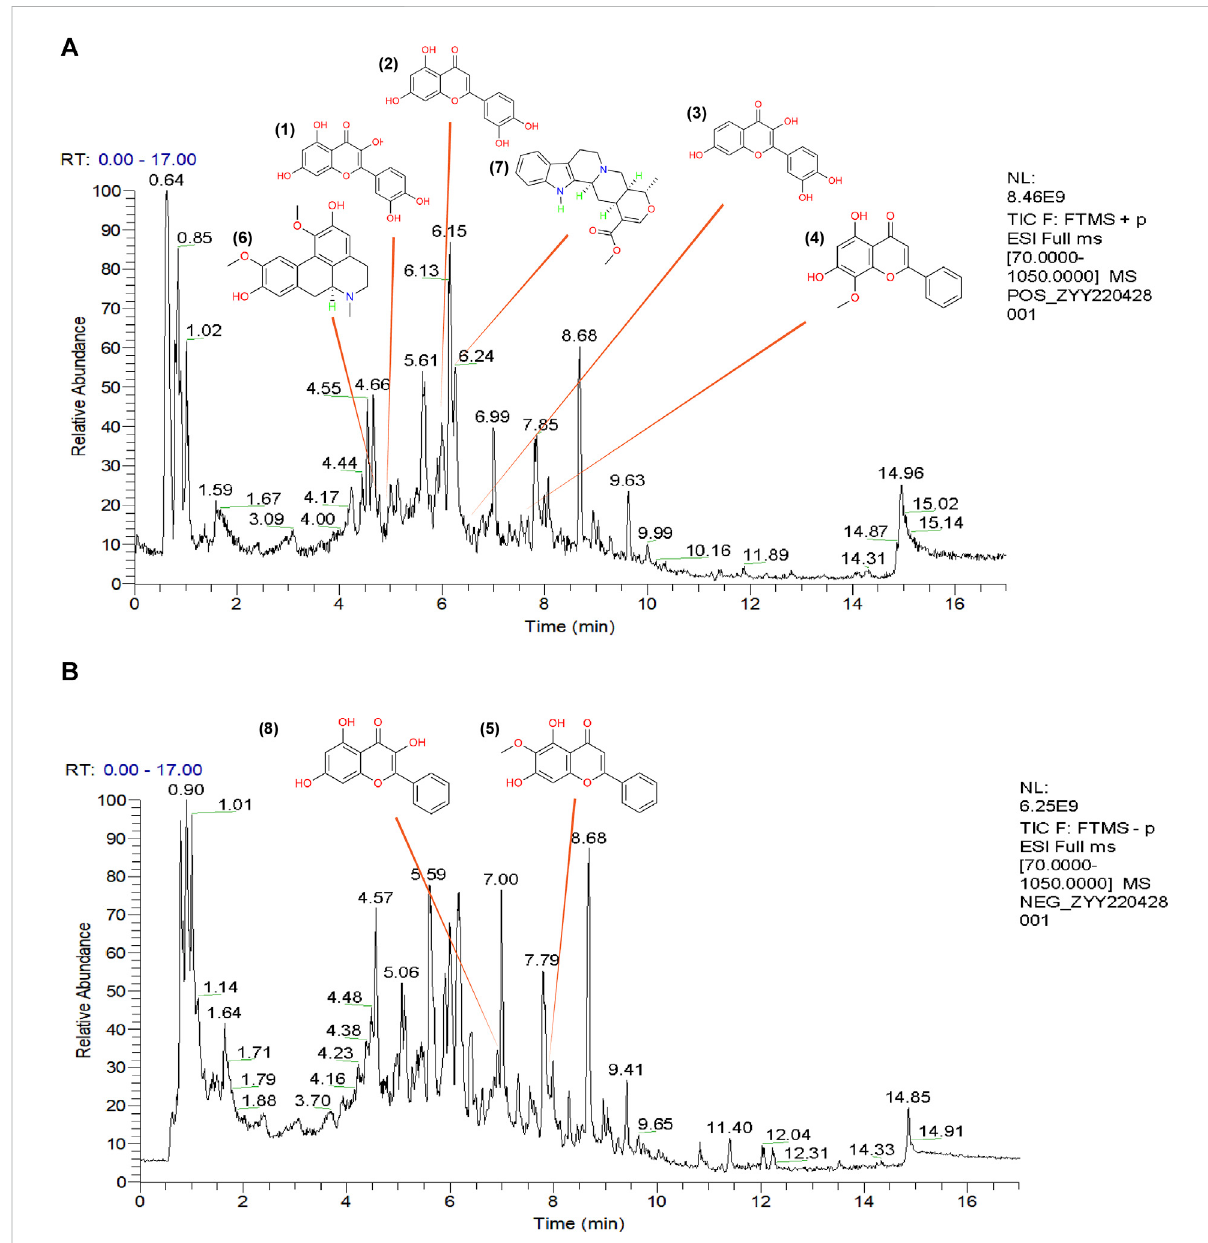
FIGURE 3 The total ion chromatograms (TICs) of TGD and chemical structure of the core components. (A) TIC of TGD in negative ion mode. (B) TIC of TGD in positive ion mode. 1) quercetin, 2) luteolin, 3) fi setin, 4) wogonin, 5) oroxylin A, 6) boldine, 7) tetrahydroalstonine, 8)